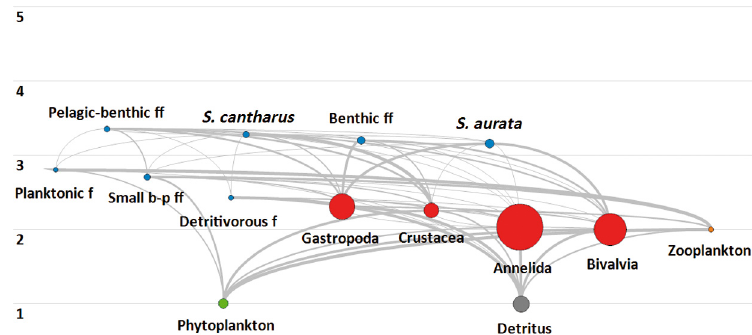
Fig. 2. Food web structure at a Ria Formosa water pond, with comparable environmental characteristics to the ones found at the lagoon tidal channels (based on Gamito & Erzini 2005). Functional fish groups: pelagic and benthic feeders, Spondyliosoma cantharus , benthic invertebrate feeders, Sparus aurata , planktonic feeders, small pelagic-benthic feeders, detritivorous fish. Macro - invertebrate groups: Crustacea, Gastropoda, Bivalvia and Annelida. The 3D volume represented by each circle is proportional to the average biomass of the functional group. Numbers = trophic levels. Colours as in Fig. 1. ff: feeder fish; f: fish; b-p ff: pelagic-benthic feeder